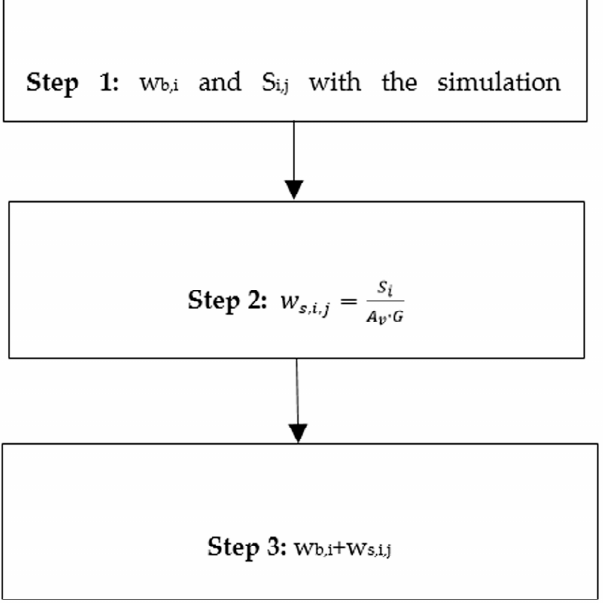
Figure 4. Flow chart to calculate the actual rotations in beams.